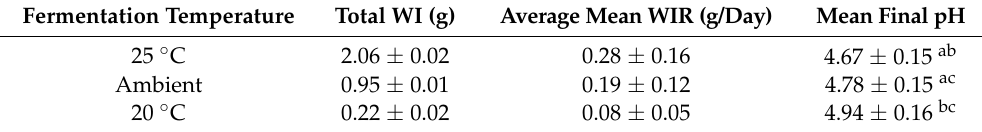
Figure 1. Weight increase of kefir grains (a) and pH variation (b), during the fermentation of milk at 24 h fermentation cycles (FC) at different temperatures. Table 1. Total weight increase (WI) of kefir grains, mean average weight increase rate (WIR) and mean final pH values, during the fermentation of milk at 24 h fermentation cycles at different temperatures. Values in each column that share the same letter do not differ significantly from each other (Mann – Whitney U-test).